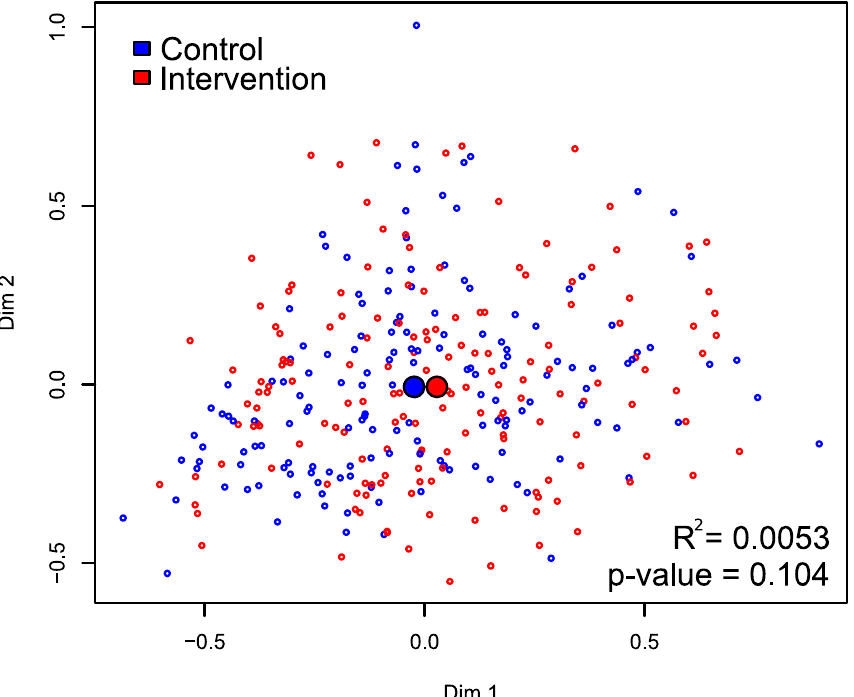
Figure 5. Multidimensional scaling (MDS) plot comparing control and intervention. The spatial separation between points represents the degree of the compositional Manhattan distance of the microbiota between samples. The x and y axes are unitless dimensions, although (0,0) represents the center of mass of all samples. Control and intervention samples are colored blue and red, respectively. The large blue and red circles represent the centroid of each group. PERMANOVA estimated a small difference (R 2 = 0.0053) that was marginally statistically insignificant ( p -value =